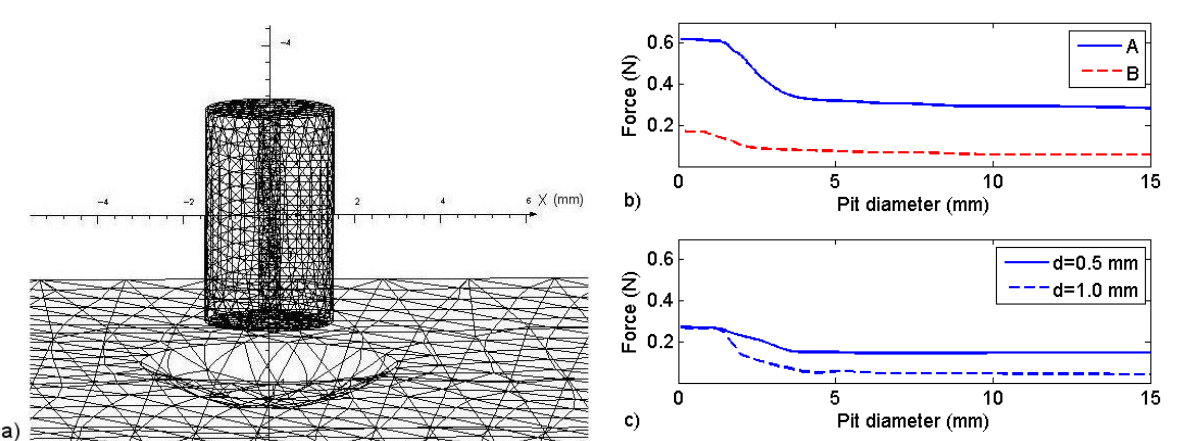
Figure 9. ( a ) Three-dimensional FEM model including a magnet with a 1.5-mm radius and a 6.0-mm diameter semi-spherical pit; ( b ) FEM results of the force for sensor A (solid line) and sensor B (dashed line) with a 0.5-mm standoff distance versus the pit diameter with a 0.5-mm depth; ( c ) The force on sensor A with a 1.0-mm standoff distance versus the pit diameter having 0.5-mm depth (solid line) and 1.0-mm depth (dashed